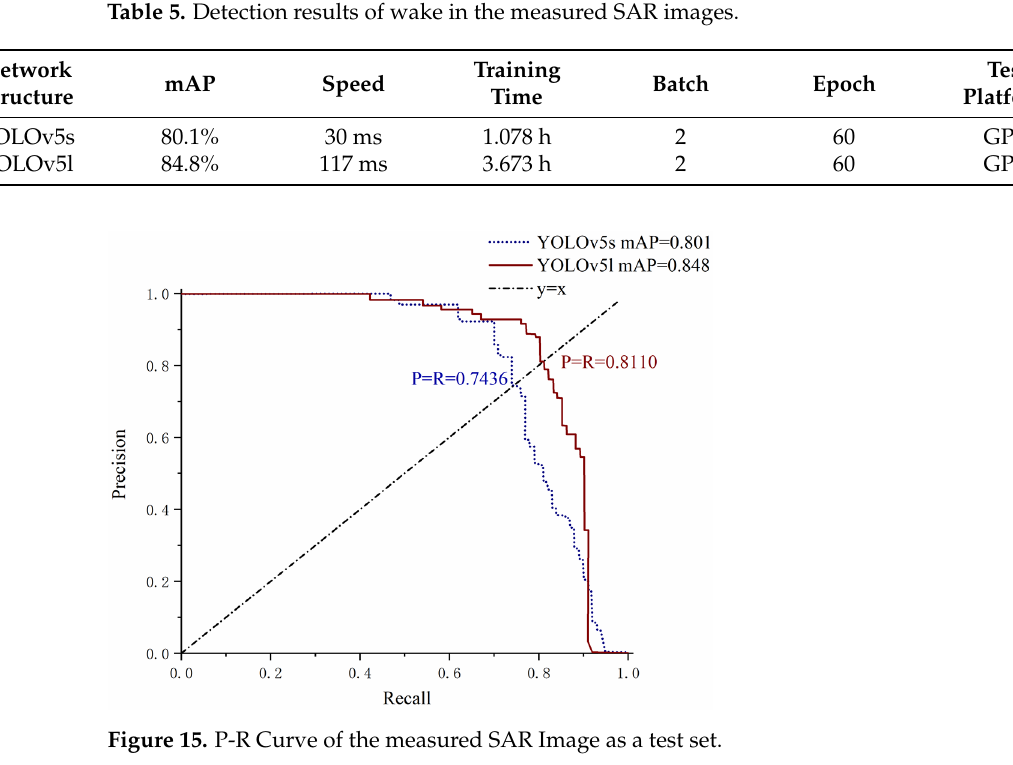
15 of 20 Table 4. Training results of simulated wakes based on different network structures of YOLOv5. Test Set Environmen- tal Factor